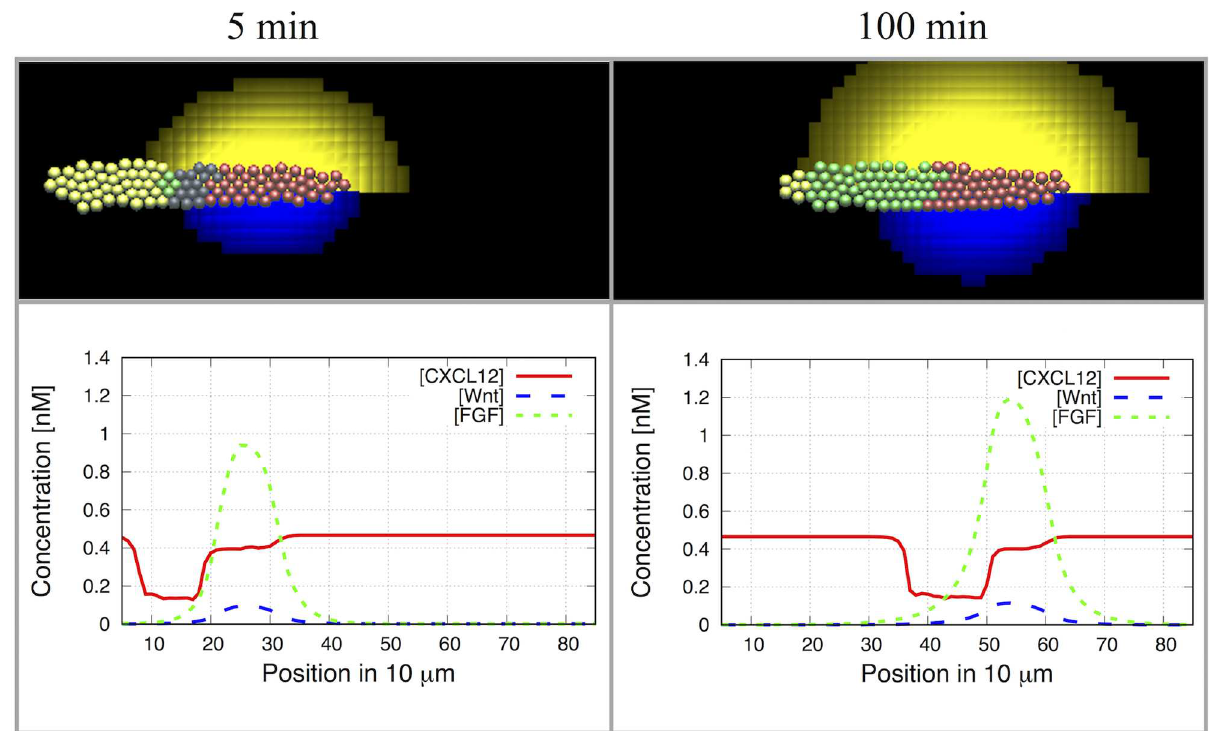
Fig 9. Successful migration in the discrete cell model. Simulations of the migrating primordiumshowingWntR expressingcells (red), FGFR expressingcells (green), WntR and FGFR expressingcells (yellow) and indeterminate cells (grey). Left: at 2 min, Right: at 100 min. Bottom row: concentrations of CXCL12a(red), FGF (green) and Wnt (blue). Parameters as in Table A in SupportingInformation S6 Text. Parameter Estimation and Values. See Fig. C in Supporting Information S5 Text. Additionalresults and details, for a more detailedtime sequenceand SupportingInformation S1 Movie. 3D simulationof PLLP migration, for a 4 hour movie of the simulationresults.